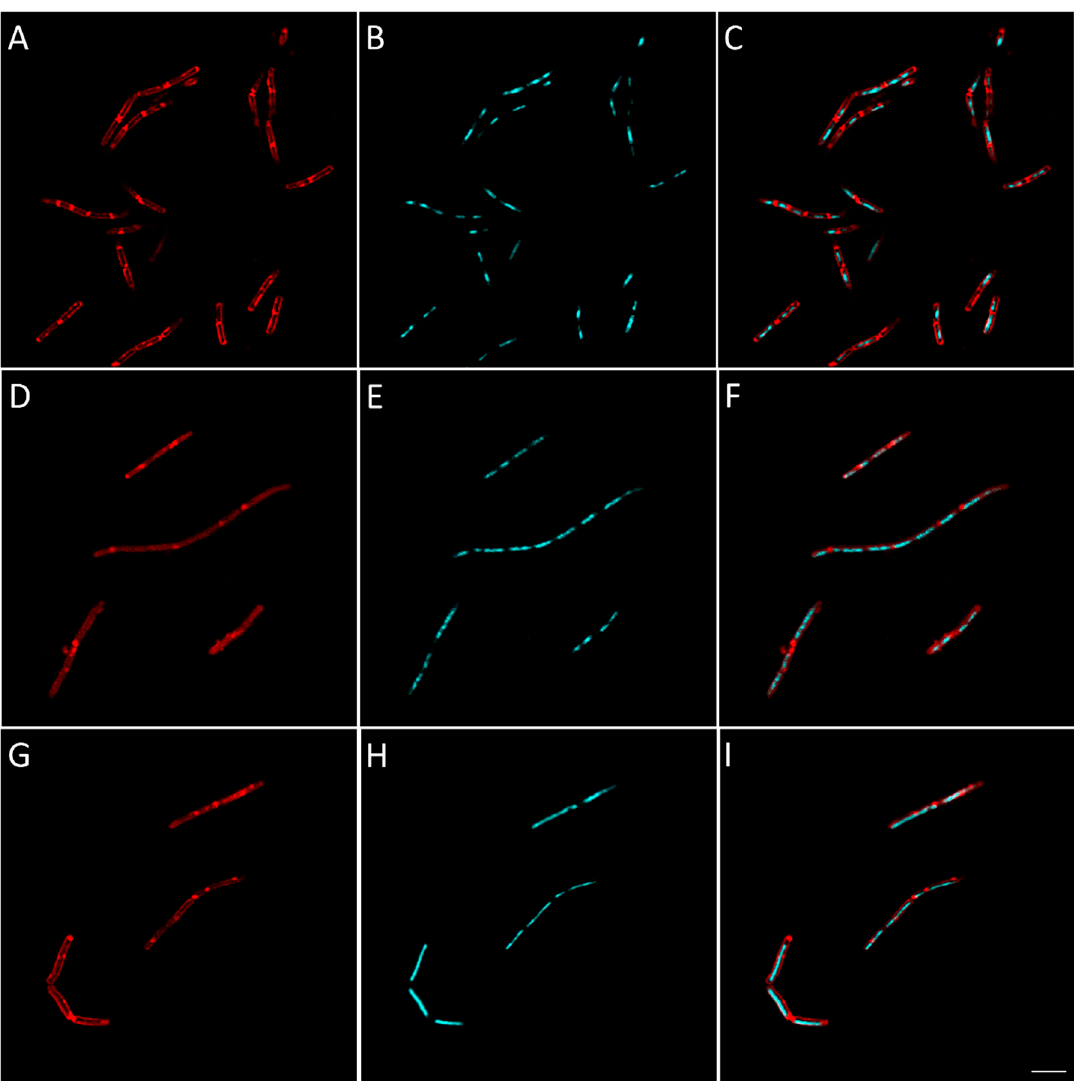
Figure 9. Morphological bacterial changes caused by compound 25 in B. subtilis . Morphological changes of B. subtilis caused by compound 25 were studied as explained in the Materials and Methods section. B. subtilis was incubated for 2 h at 37 °C in aerobic conditions with 4 X MIC of 25 ( D – F ). Control ( A – C ) was bacteria with no antibiotics added. At the end of the incubation, bacteria were fixed and membrane ( A , D , G ) and DNA ( B , E , H ) were stained using FM4-64FX (red signal) and DAPI (blue signal), respectively. Membrane and DNA signals were merged in the figure in ( C , F , I ). The effect of rifampicin, inhibiting RNA synthesis, is shown for comparison in ( G – I ). Bacteria were observed using confocal microscope and images representative of observed effect were taken. The white scale bar on the bottom right corner corresponds to 4 µm.